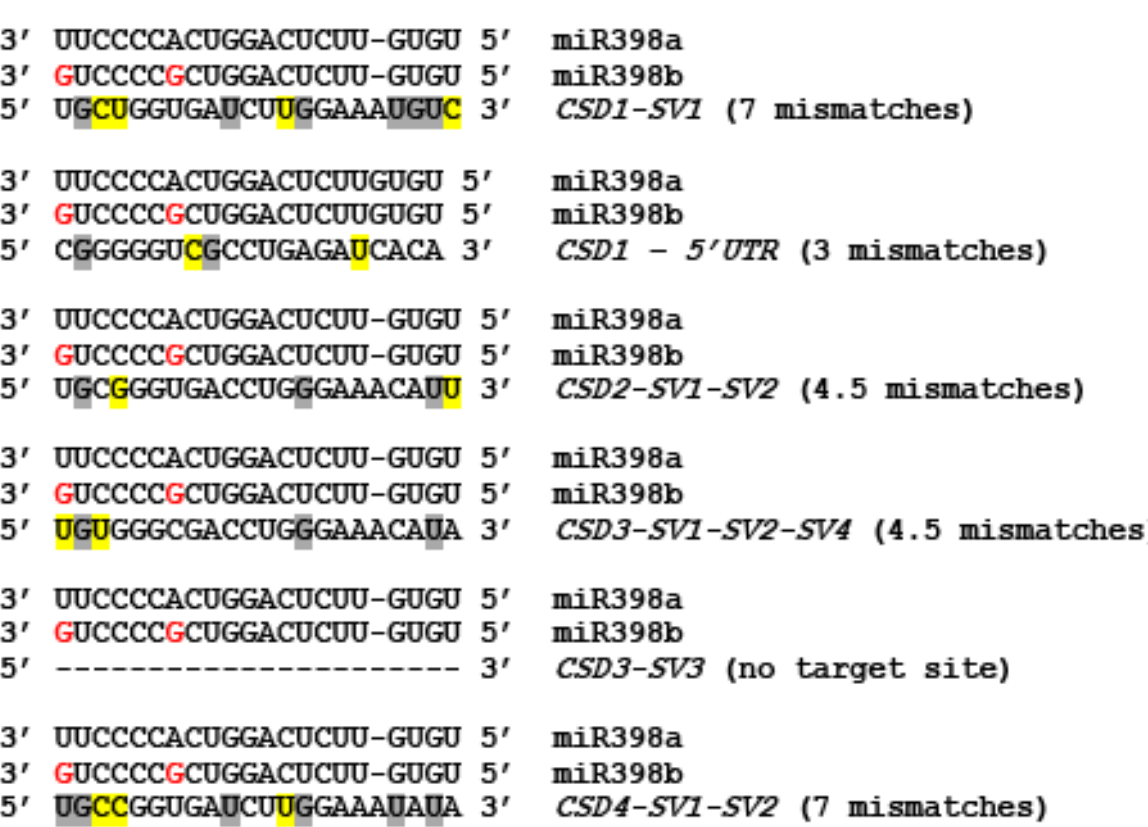
Figure 8. Sequence alignment of miR398 and miR398 target sites with the four rice CuZn-SODs . Top panel shows the miR398a and miR398b sequence and the variations (indicated in red font color). The bottom panel shows the mismatches (shaded in yellow color) and G:U wobble (shaded in grey color) in the corresponding target region of the target transcripts. Some G:U pairs are not grey shaded because those ‘G’ can be perfectly paired with ‘A’ present in one of the miR398s.